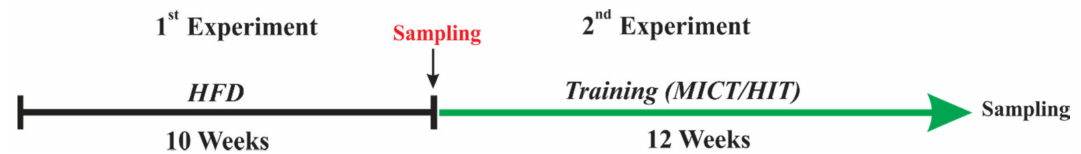
Figure 1. Experimental design. The first part of the experiment was designed for determining the e ff ect of obesity (10 weeks) and the second part to determining the e ff ect of 12 weeks of either moderate- intensity continuous training (MICT) or high-intensity interval training. (HIIT). HFD: high-fat